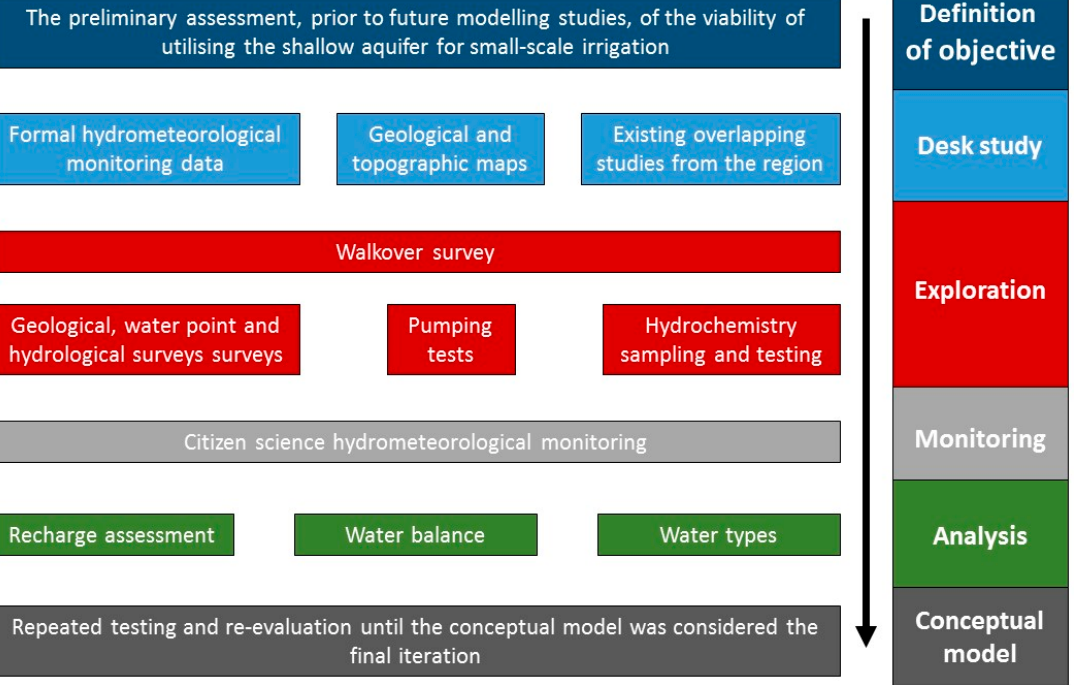
Figure 3. Methodological flowchart showing the stages (right) and corresponding methods involved in developing the conceptual model (adapted from Brassington and Younger [17]). While there is a general progression from top to bottom, many of the methods were applied simultaneously or out of chronological sequence (as indicated by the final box: “Repeated testing and re-evaluation…”). For example, citizen science hydrometeorological monitoring occurred throughout the project beginning immediately after the walkover survey and was continually analysed as data were received.